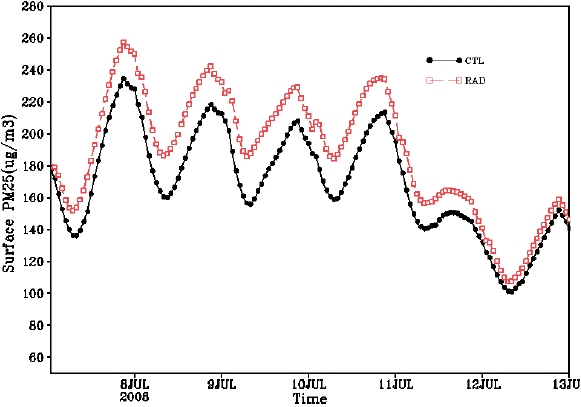
Figure 9. Temporal changes of LAND-averaged surface PM 2 . 5 by the CTL and RAD